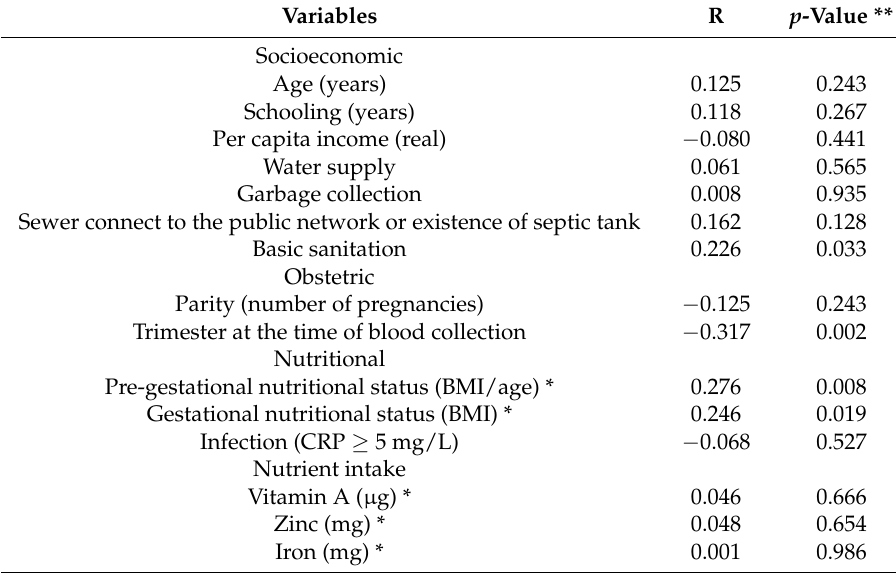
Table 3. Pearson’s correlation coefficient of serum retinol levels * with different